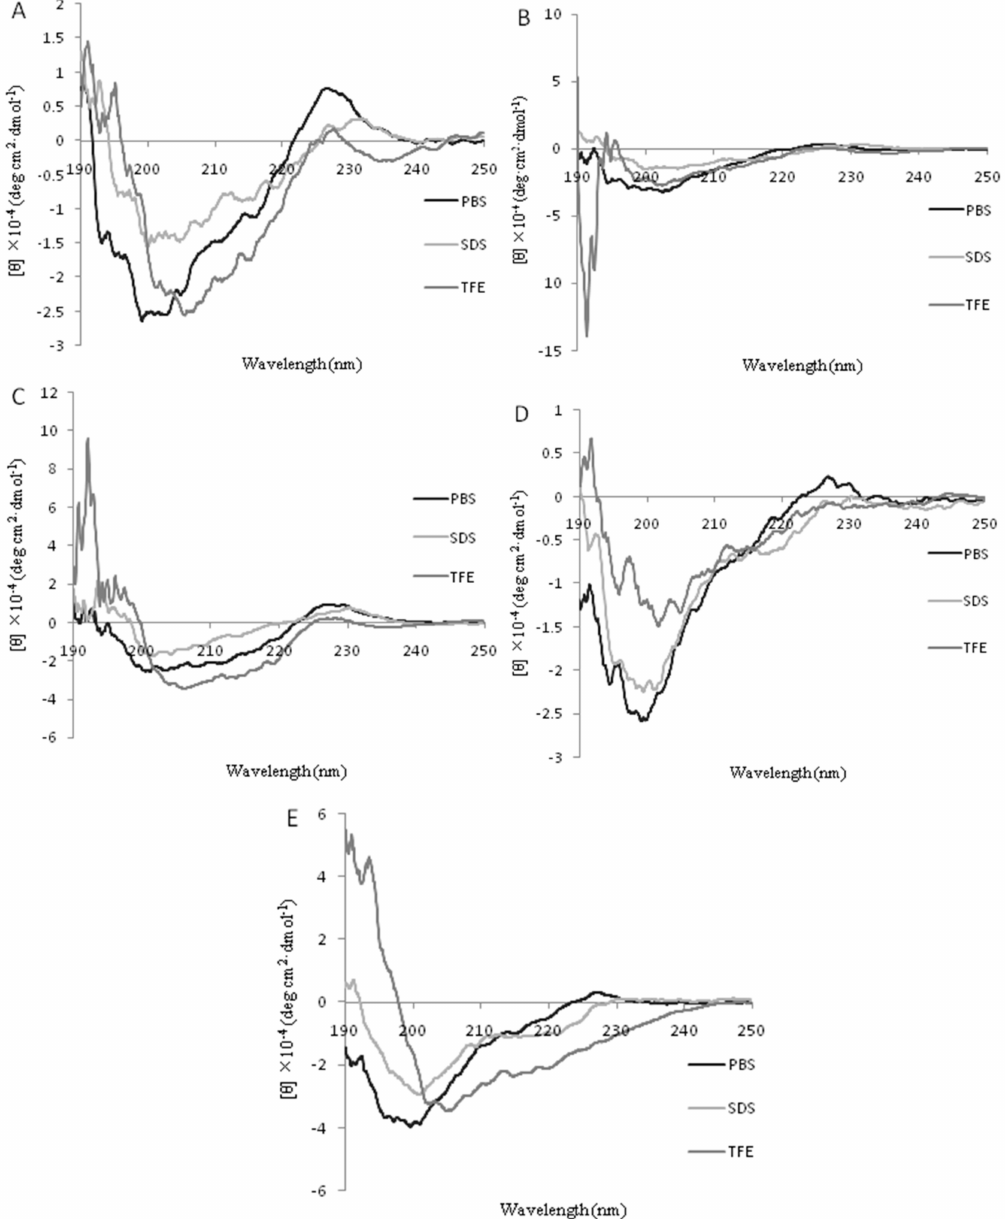
Figure 2. The Circular Dichroism (CD) spectrum of each peptide. The mean residue ellipticity was plotted against wavelength. The values from three scans were averaged per sample, and the peptide concentrations were fixed at 40 µ M. ( A ) KW-WK; ( B ) FP-PF; ( C ) FW-WF; ( D ) KK-KK; ( E )